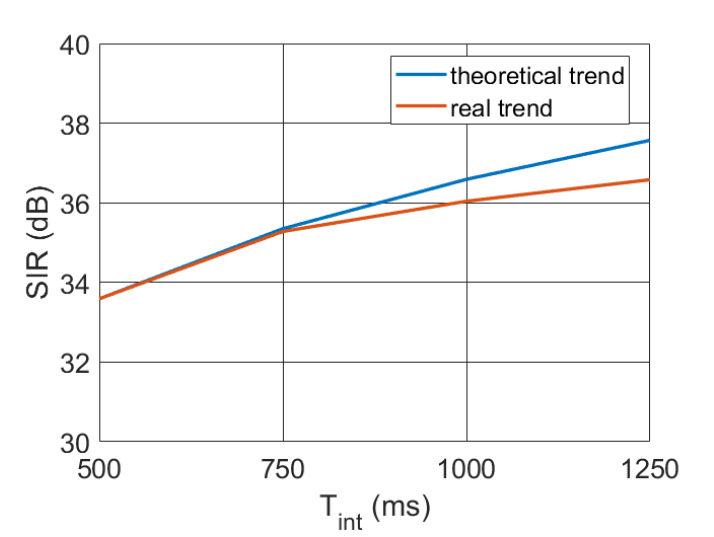
Figure 19. Study of SIR improvent versus integration time.